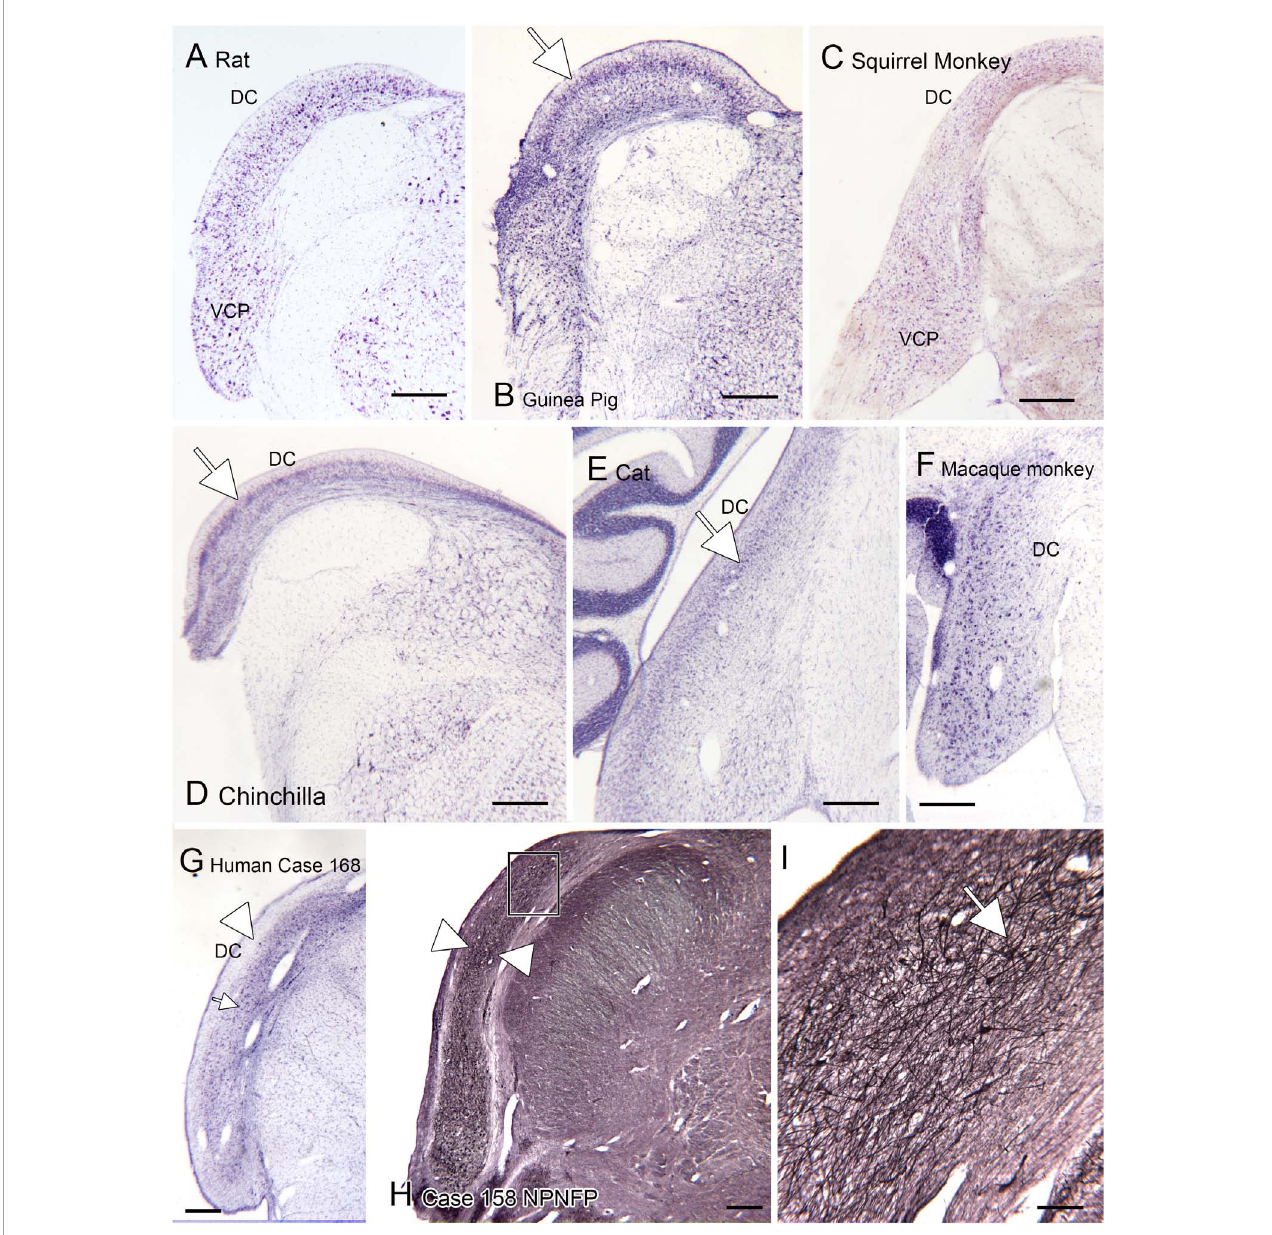
FIGURE7 The dorsal cochlear nucleus (DC) in rat (A) , guinea pig (B) , squirrel monkey (C) and chinchilla (D) . (E) Cat. The arrow shows the layer of fusiform cells in the DC. (F) The DC in macaque monkey. (G) The DC in the human; CV-stained section. The arrowhead indicates an outer cell-sparse band about 200 µ m thick. Deep to that band are scattered somata (example at arrowhead). (H) Expression of non-phosphorylated neurofilament protein (NPNFP) in the DC of the human. There is a broad band of immunolabel (between the arrowheads). The rectangle shows the location of the image in panel (I) . (I) The band of label is comprised of NPNFP-ir neurons (example at arrow) and a dense meshwork of immunostained processes. Scale bars: (A–H) = 500 µ m; (I) = 100 µ